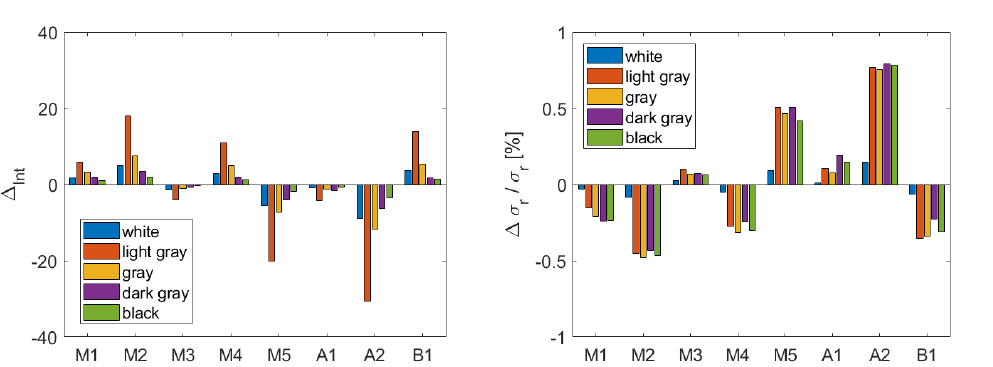
Figure 12. Left : Difference between intensity values of measurement one and those from the other measurements at a distance of 15 m; Right : Percentage of the corresponding differences of the range precision. M1-M5: Measurements, that were taken one by one; A1, A2: Measurements after restarting the instrument; B1: Measurement after changing the battery.